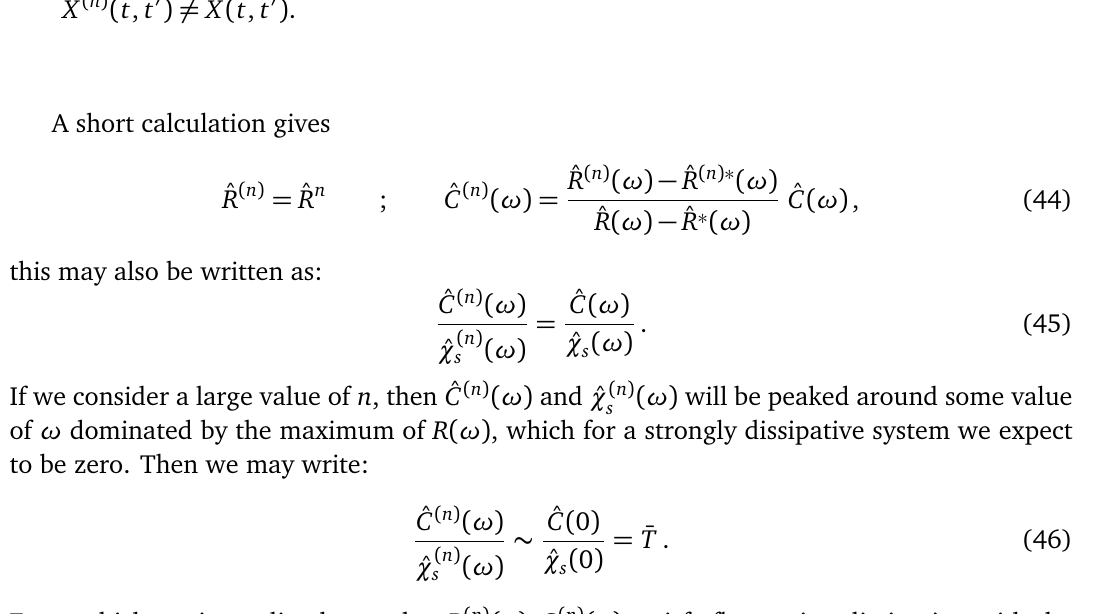
Figure 2: Illustration of the fact that C ( n ) and χ ( n ) become broader and broader with n , X ( n ) and essentially flat. Within that range, if X ( C ) is not a constant, then X ( n ) ( t , t ′ ) ̸ = X ( t , t ′ )